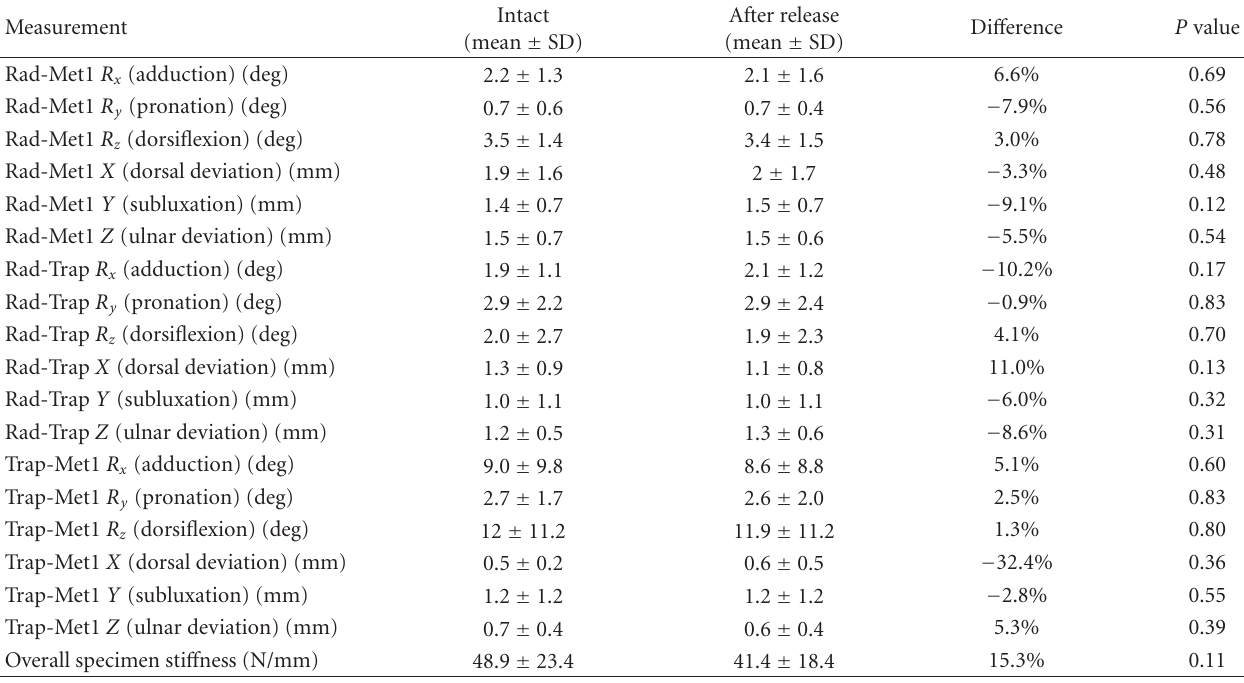
Table 1: Summary of mechanical properties for each combination of bones before and after open carpal tunnel release.